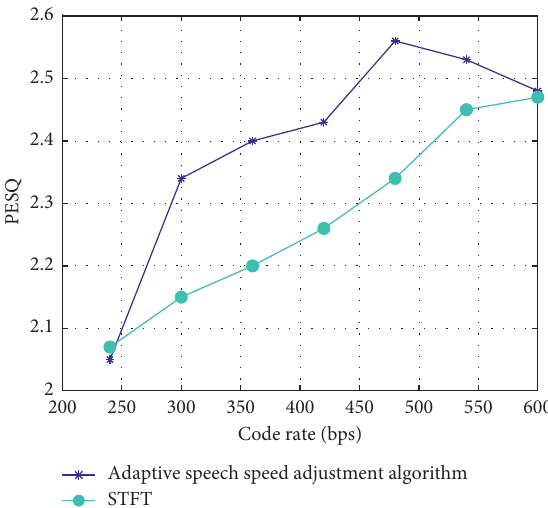
Figure 4: PESQ score corresponding to 200BPS–600BPS